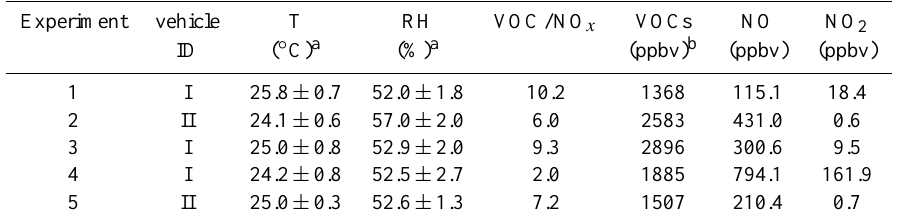
Table 2. Initial conditions for the light-duty gasoline vehicle photo-oxidation experiments. Experiment